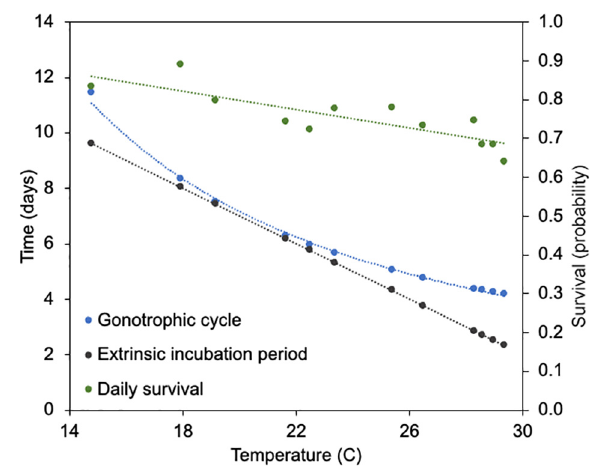
FIGURE 4 | Relationship between temperature, gonotrophic cycle length, extrinsic incubation period for eastern equine encephalitis virus and daily survival of Cs. melanura from Central Florida. Temperature represents average monthly temperature in Orange and Polk County, FL, United States, in